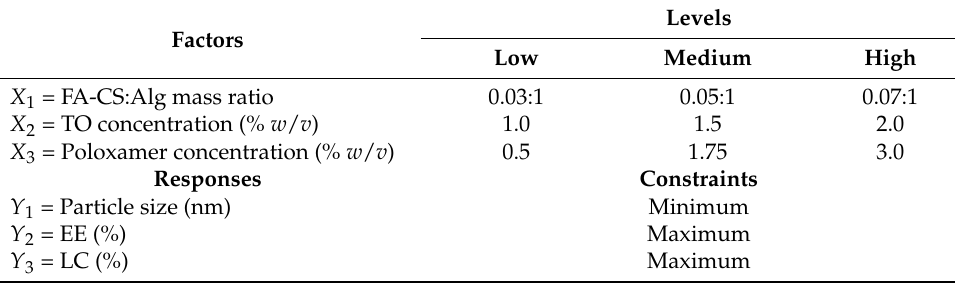
Table 1. Factors and responses for the